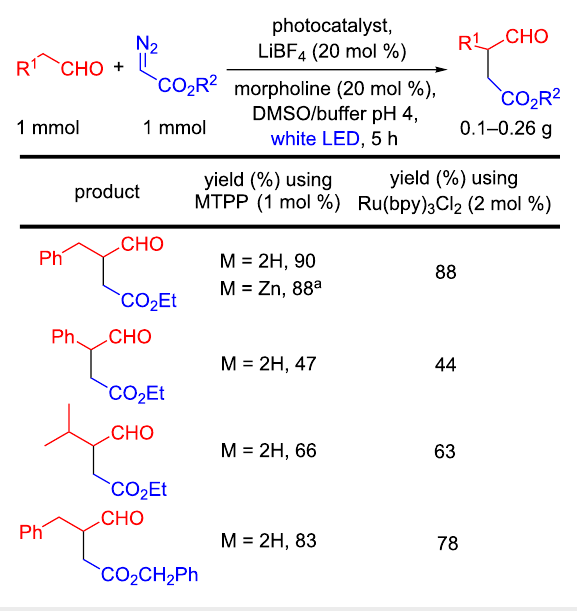
Scheme 1: Photoredox alkylation of aldehydes with diazo acetates using porphyrins and a Ru complex. a Using a loading of 0.1 mol % for